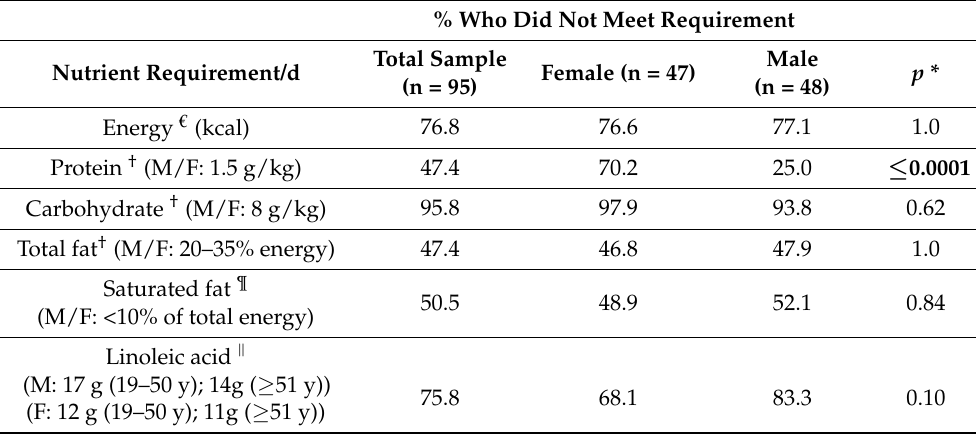
Table 4. Proportion of endurance athletes with inadequate nutrient